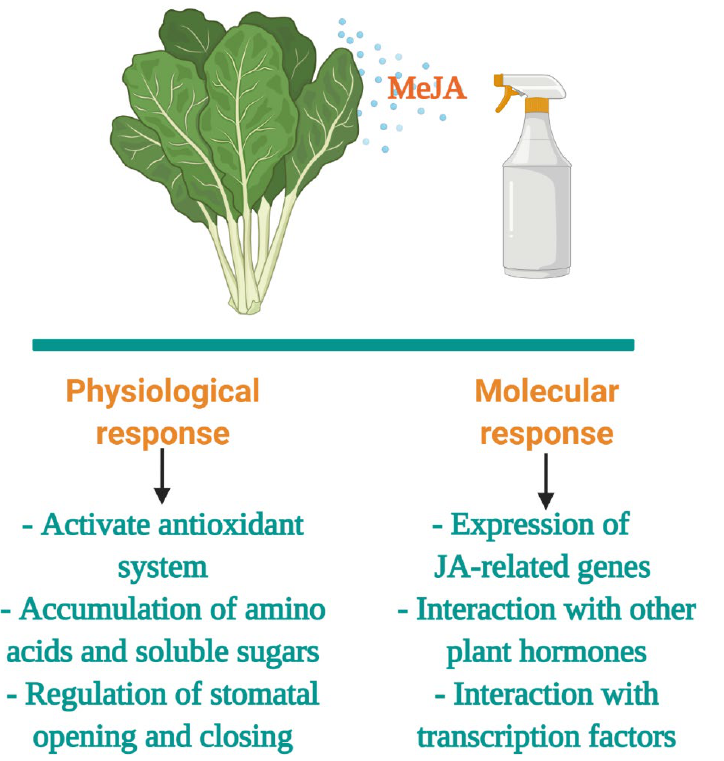
Figure 4. General mechanisms and functions in methyl jasmonate (MeJA) stress tolerance of plants. Figure created with BioRender.com (accessed on 20 October 2021).